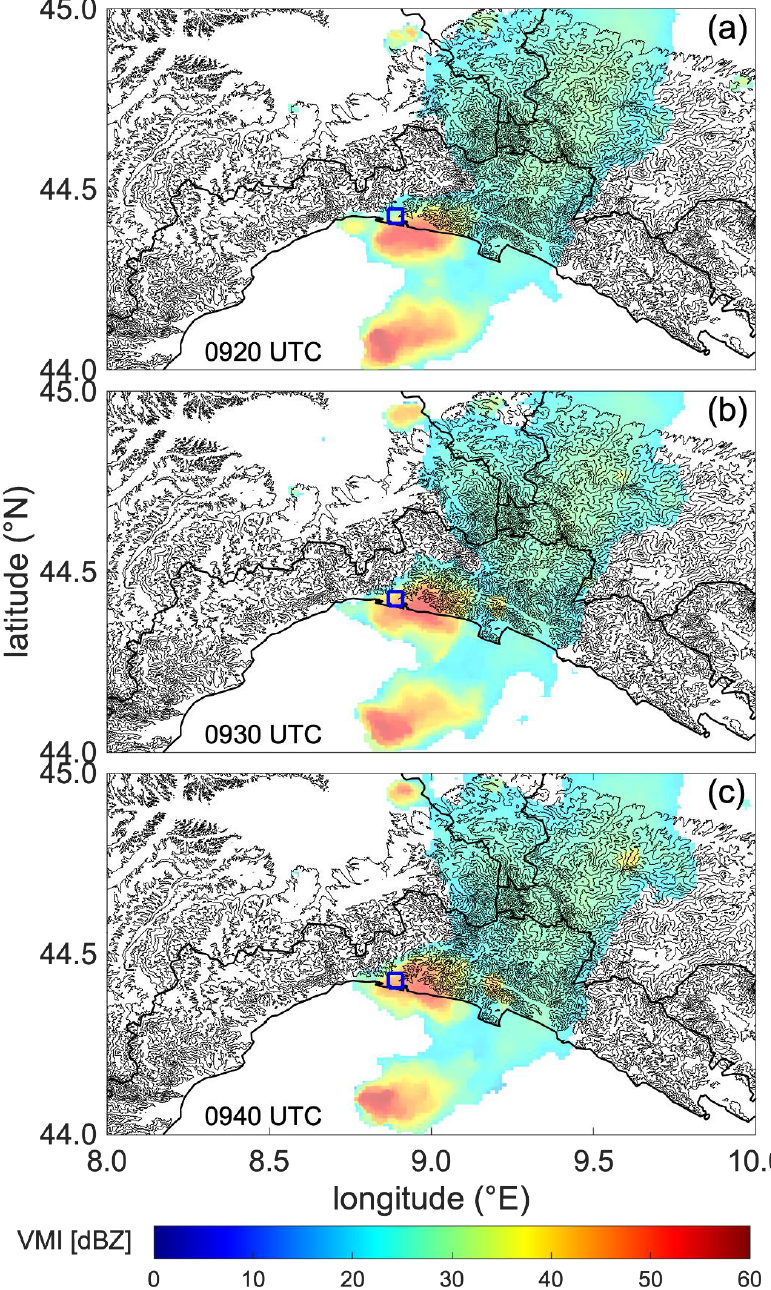
Figure 5. Radar reflectivity (dBZ) measured by the Ligurian Doppler radar. The panels ( a – c ) show three consecutive VMI (Vertical Maximum Intensity) images at 09:20, 09:30, and 09:40 UTC, respectively. The position of Morandi bridge is indicated by the black cross.